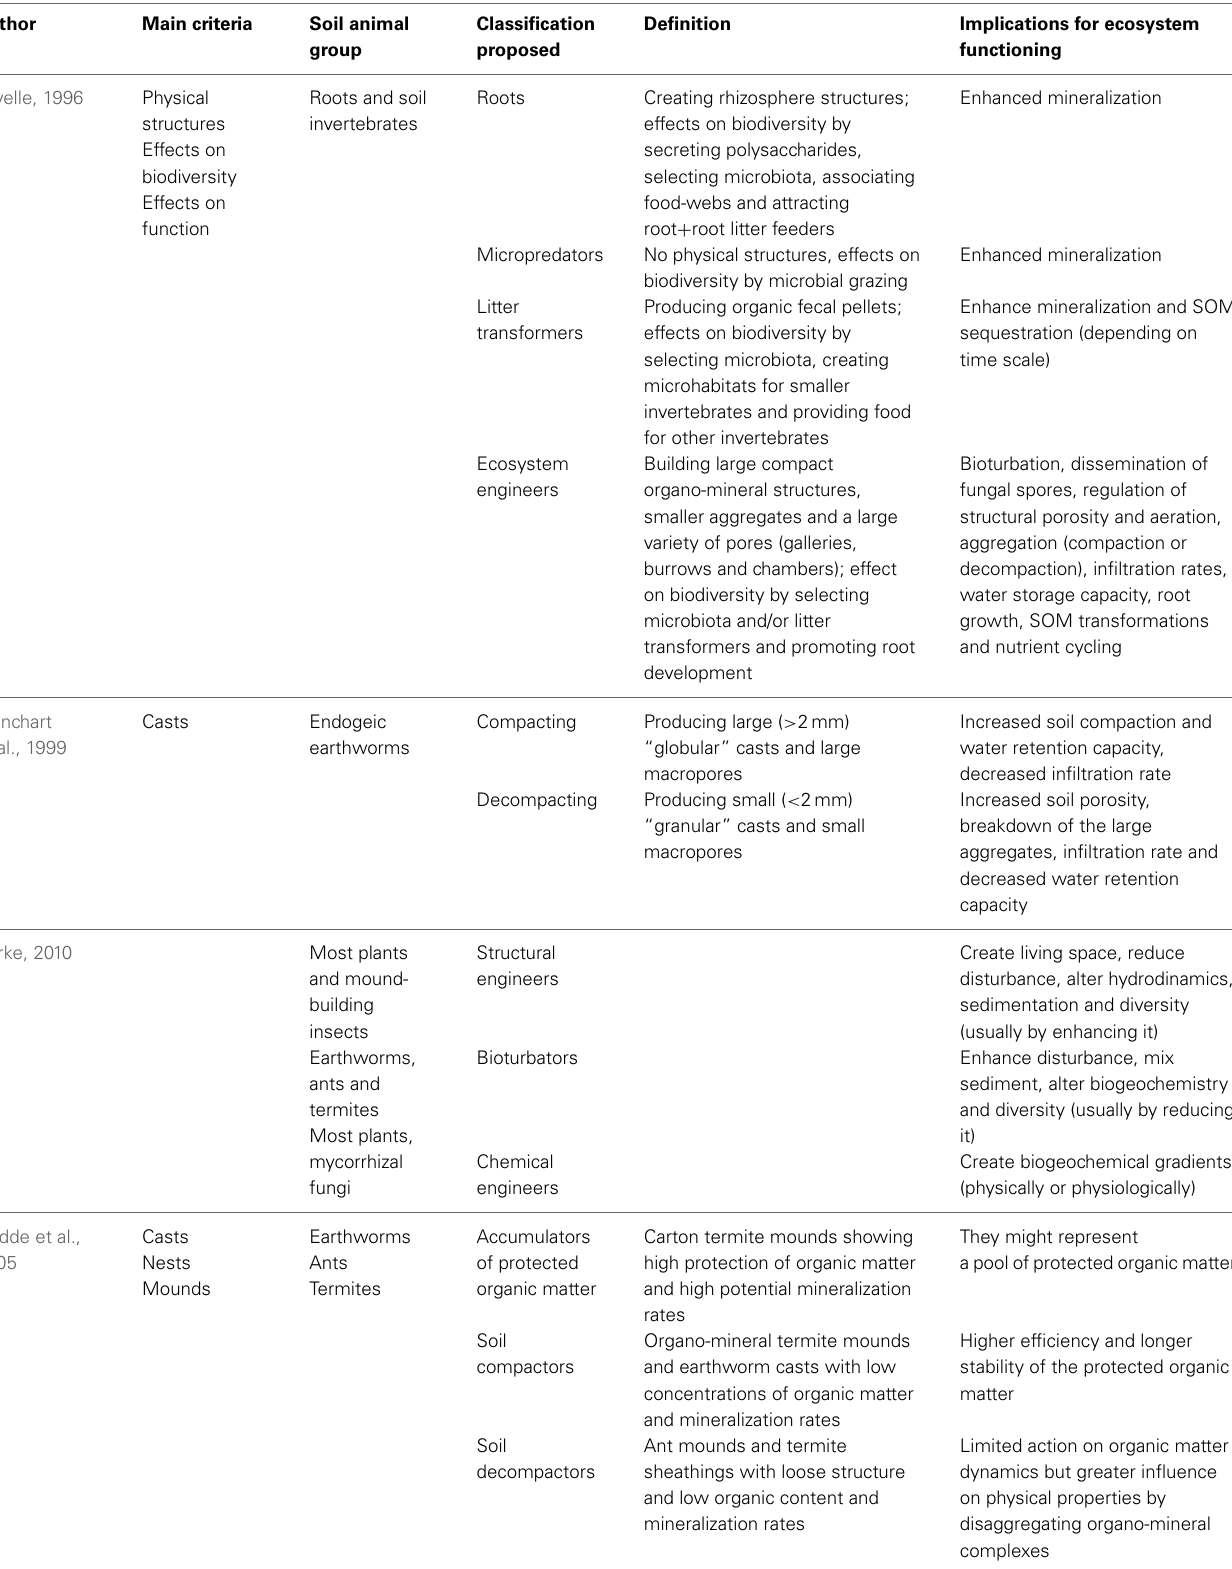
Table 2 | Functional classifications based on the pivotal role of ecosystem